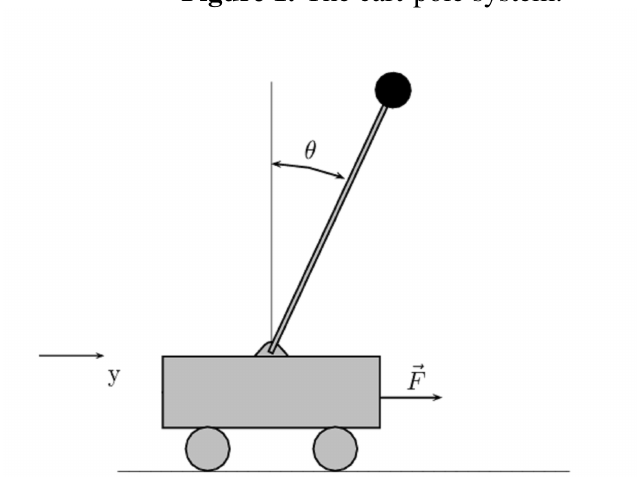
Figure 1. The cart-pole system.